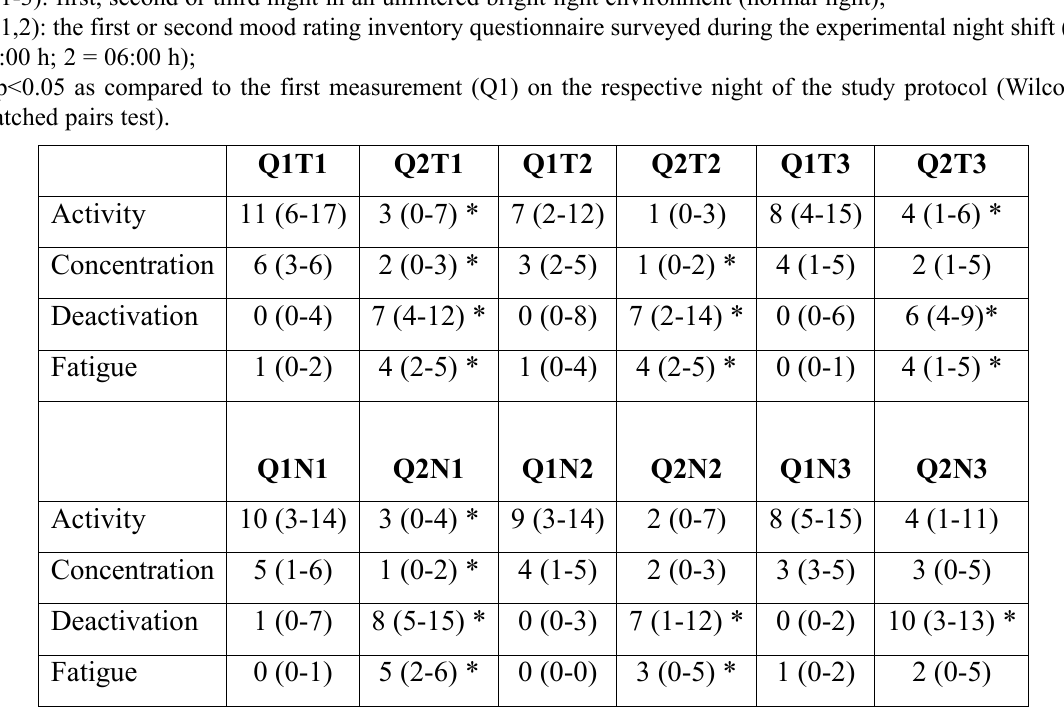
Table 2. Results of mood rating inventory questionnaires (selected parameters of the EWL adjective check list of Janke and Debus  , Hogrefe Verlag, Goettingen. Germany). Data are given as median (with the 25th and the 75th